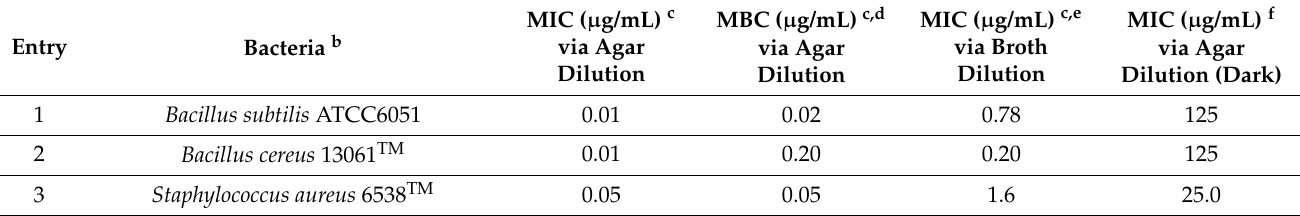
Table 2. Difference in the MIC (agar dilution vs. broth dilution) and MBC of HP-RBf under fluorescent light a